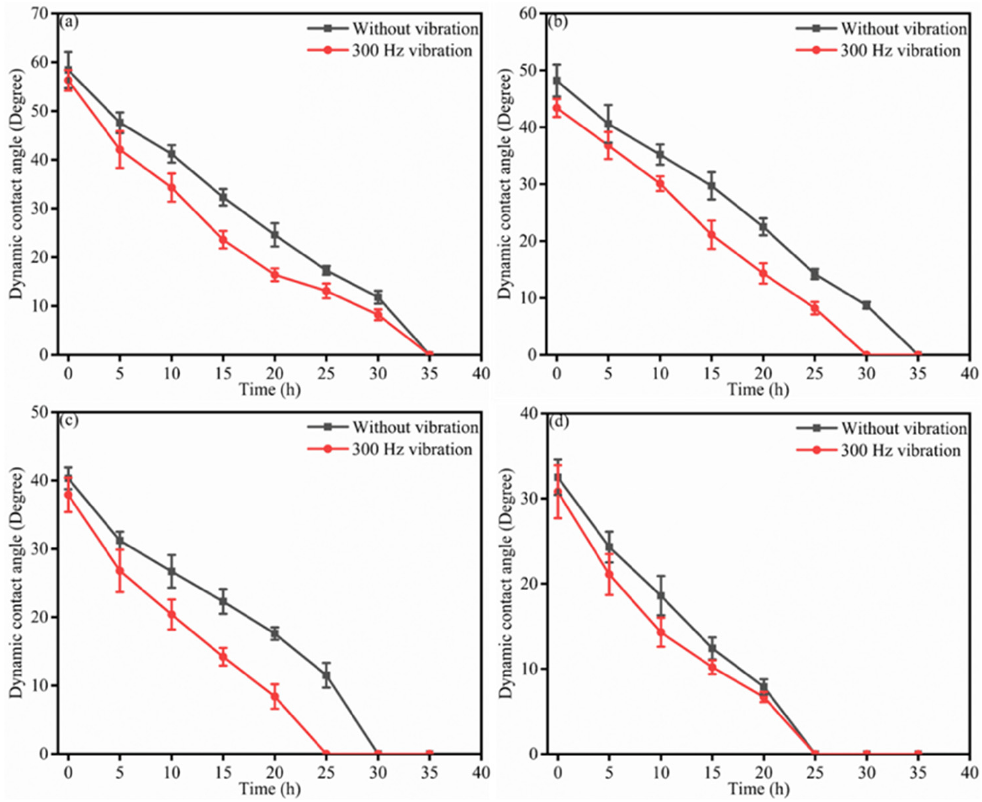
Figure 5. The gas/solid/water dynamic contact angles of water drops onto the ( a ) iron casting; ( b ) steel; ( c ) PVC; ( d ) PE, with or without 300 Hz vibration.